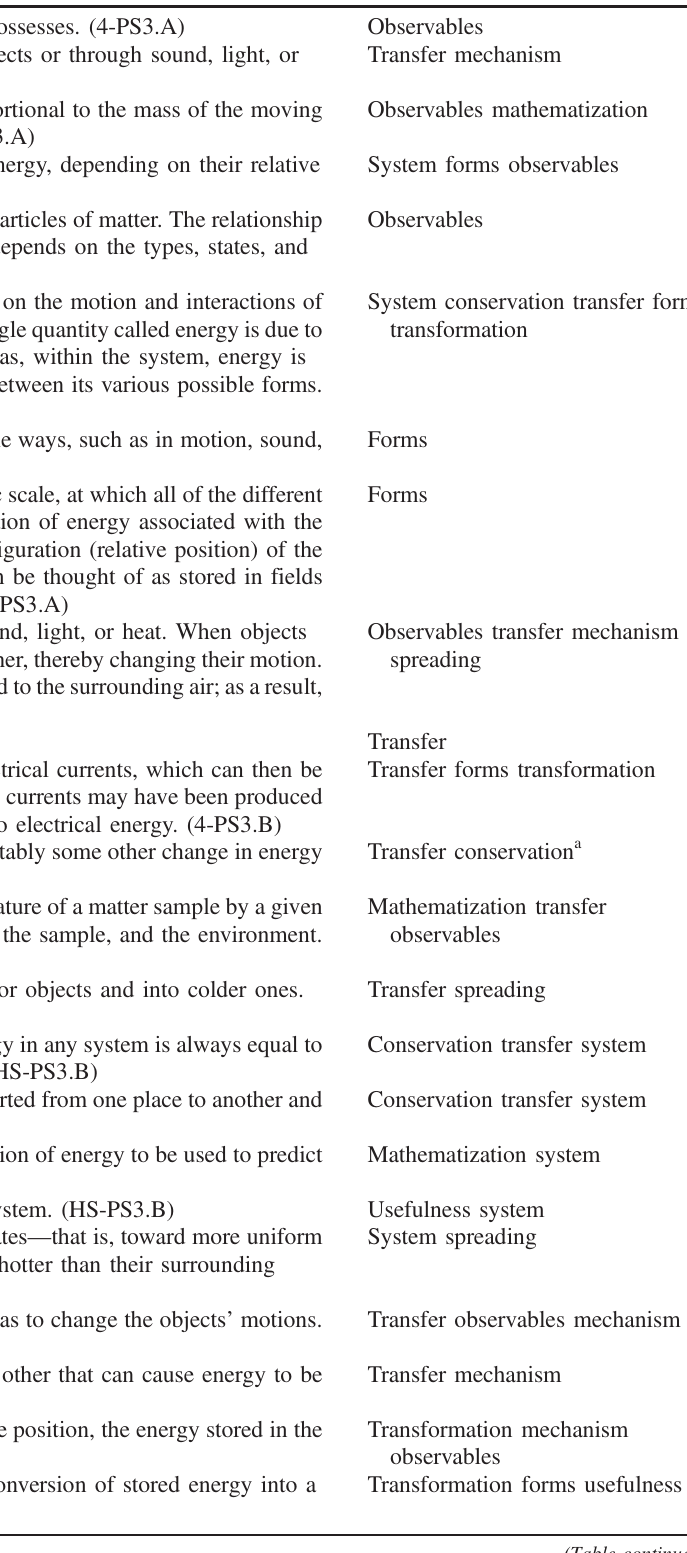
TABLE II. NGSS energy standards in the disciplinary core ideas (physical science topic 3) and their constituent ideas. Disciplinary core idea (DCI), Physical science topic